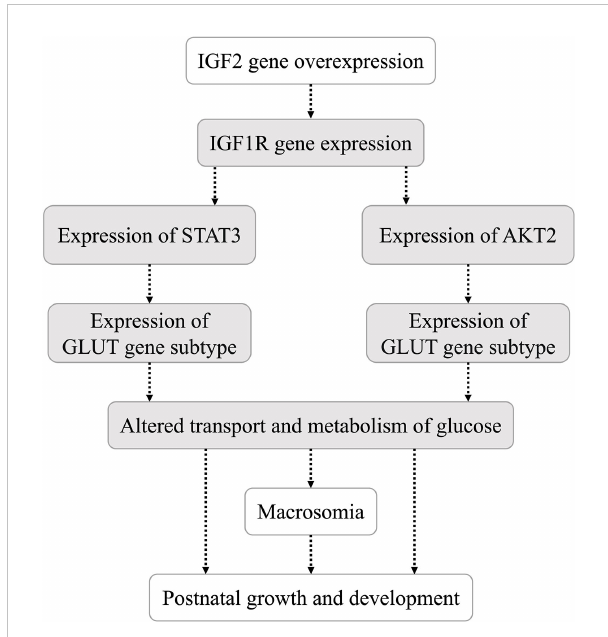
FIGURE 2 Hypothesis of the IGF2 gene downstream signaling pathway in this